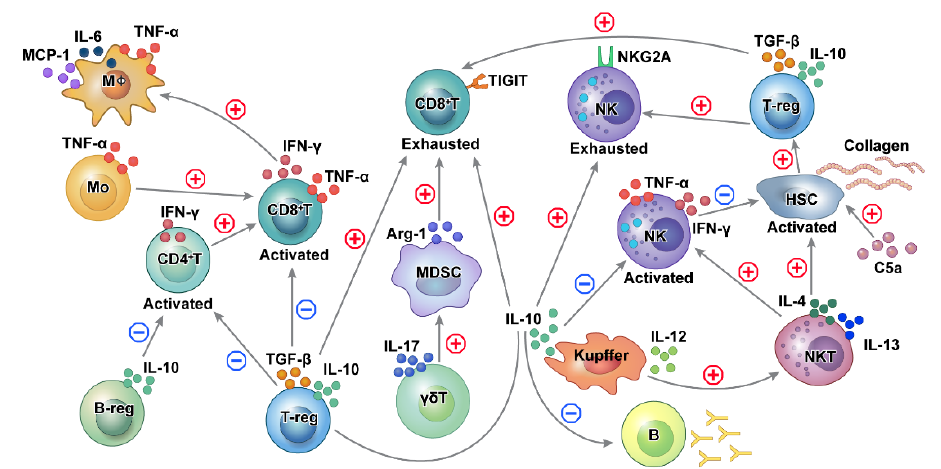
Figure 3. Schematic outline of the immune cell network in HBV-related HCC. Cross-talk and interac- tion exist among different immune cells in regulating functions promoting hepatocarcinogenesis in HBV-related HCC. In chronic HBV-induced inflammation, activation of adaptive immune cells func- tions as part of the pro-inflammatory process, while tolerance and exhaustion of adaptive immune cells reduce the detection and elimination of transformed cells. CD8+ T cells are involved in